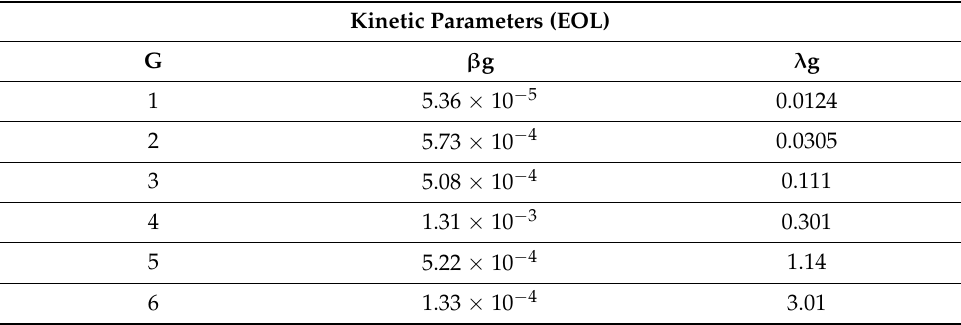
Figure 2. Algorithm of system modeling, including movement of the absorber module in iFAST. Table 1. Kinetic parameters of the large-size oxide SFR